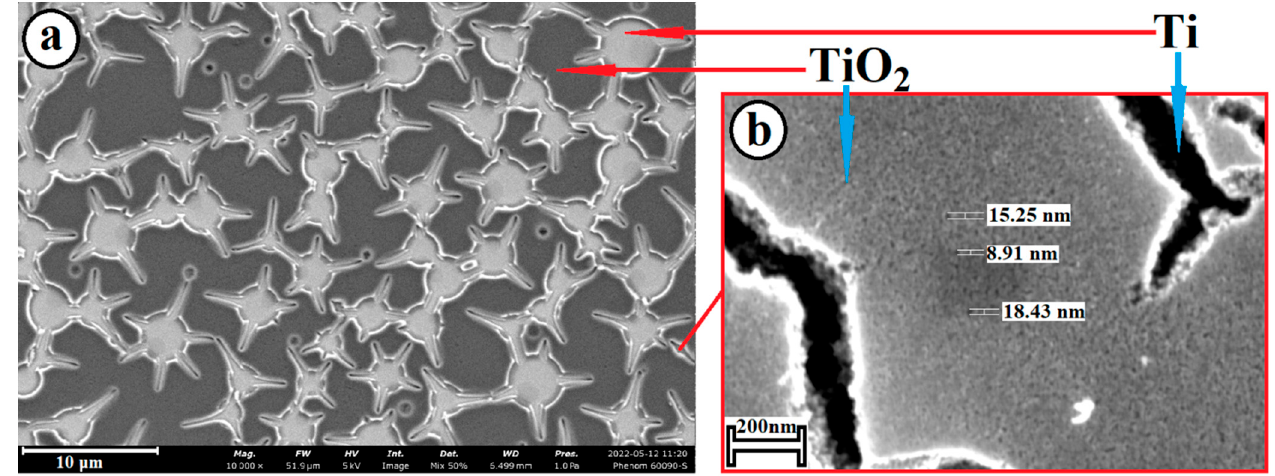
Figure 1. SEM images of TiO 2 film: ( a ) with micro-roughness; and ( b ) with nanopores. There are no anatase and rutile reflexes on the diffractogram of the resulting TiO 2 coating (Figure 2a), which indicates the X-ray amorphousness of the deposited film. However, after 1 h calcination of a TiO 2 -coated sample at 400 °C, the film becomes polycrystalline. Anatase reflexes (Figure 2b) confirm the presence of the TiO 2 phase in the sample.